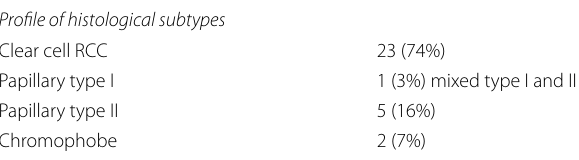
Table 3 Distribution of RCC pathological subtypes Profile of histological